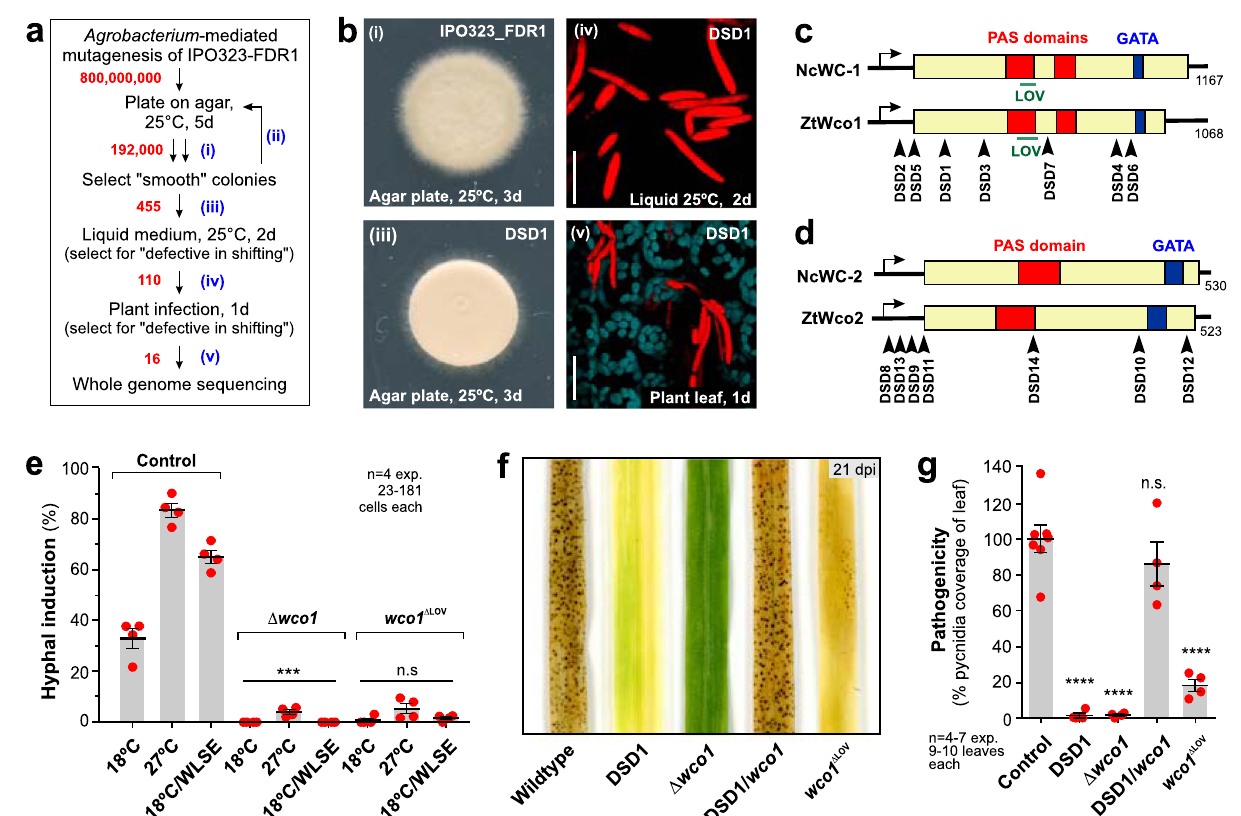
Fig.7|Ageneticscreenrevealsthelight-sensingwhite-collarcomplex(WCC)as a regulatorofdimorphismand pathogenicity. a Strategyunderlying the genetic screen for mutants defective in dimorphic switching. Mutant numbers in red, experimental steps in blue. See Supplementary Fig. 8. b Experimental steps in screen(see a ,bluenumbers).SporesintherightpanelsexpressonlymCherry(red), indicating the absence of dimorphic switching. Scale bars=15 µ m (upper right panel) and 20 µ m (lower right panel). c , d Domain structure of Z. tritici Wco1 and Wco2 and predicted mutations in DSD1-DSD7 ( c ) and DSD8 – DSD14 ( d ). NcWC1: N. crassa white-collar 1, NcWC2: N. crassa white-collar 2. Note that Wco1-encoding gene ZTRI_11.64 does not carry the 405bp deletion, previously reported for another IPO323 isolate 10 . e Hyphal programme induction in Δ wco 1 and wco 1 Δ LOV mutants. Neither mutant is induced by temperature and/or leaf cues. See Supple- mentary Figs. 9 and 10. f , g Disease symptoms (pycnidia) on leaves at 21 days after